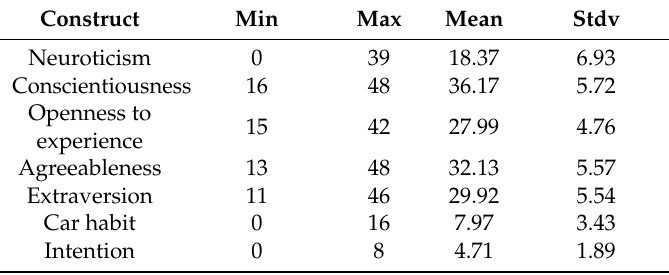
Table 1. Descriptive statistics of constructs measured based on summed scale, sample size: